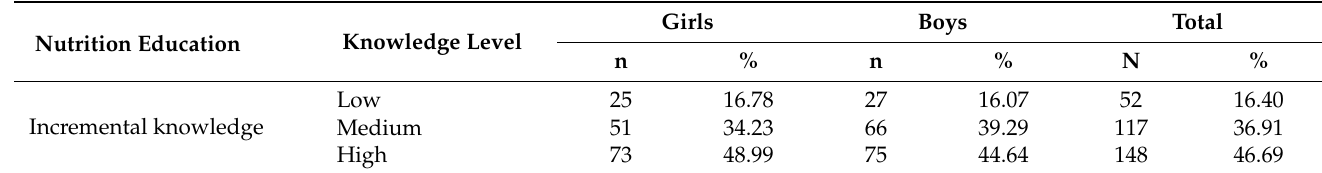
Table 4. Increase in knowledge of surveyed students after educational programme.